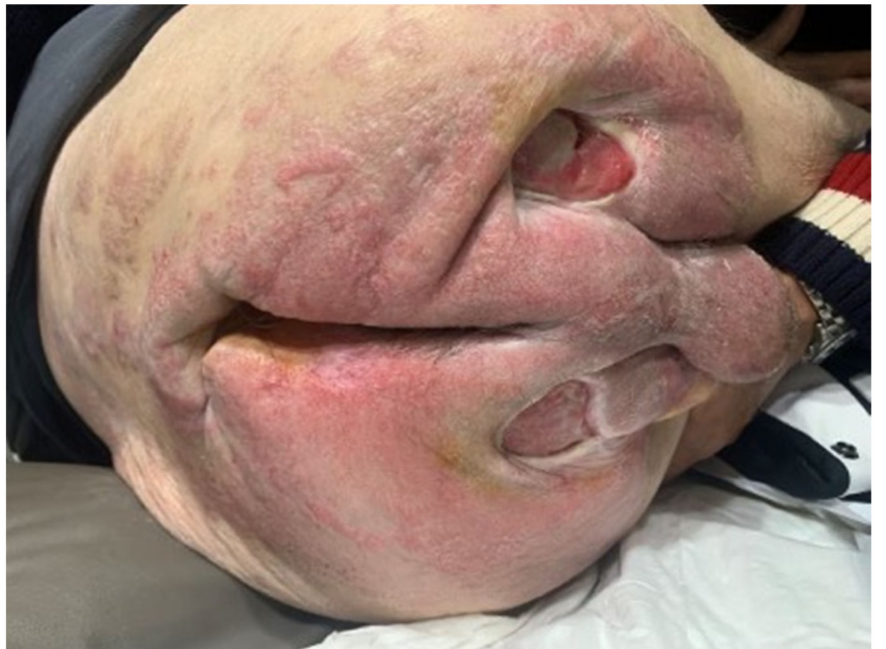
Figure 2. Situation Status one year after discharge from the